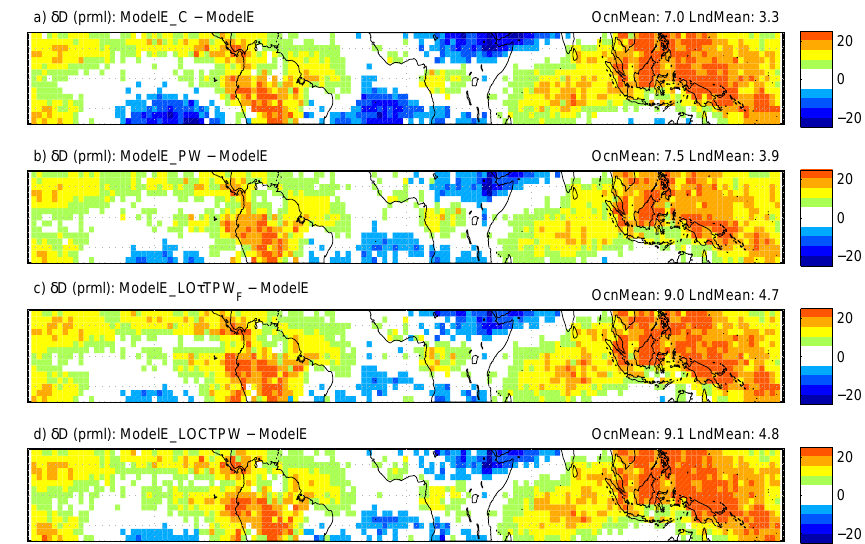
Fig. 15. Same as Fig. 14c, but for the categorical TES operator with the four representative